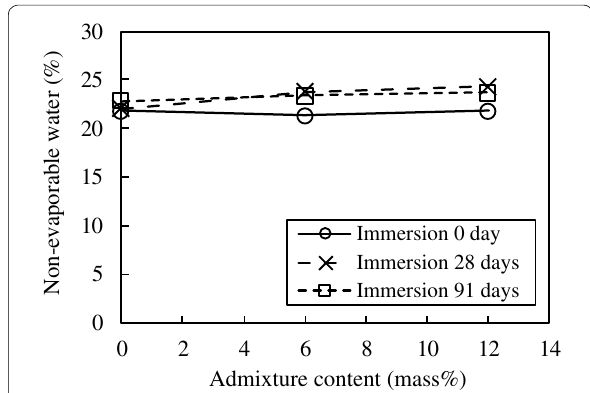
Fig. 9 Relation between admixture content and non-evaporable water.